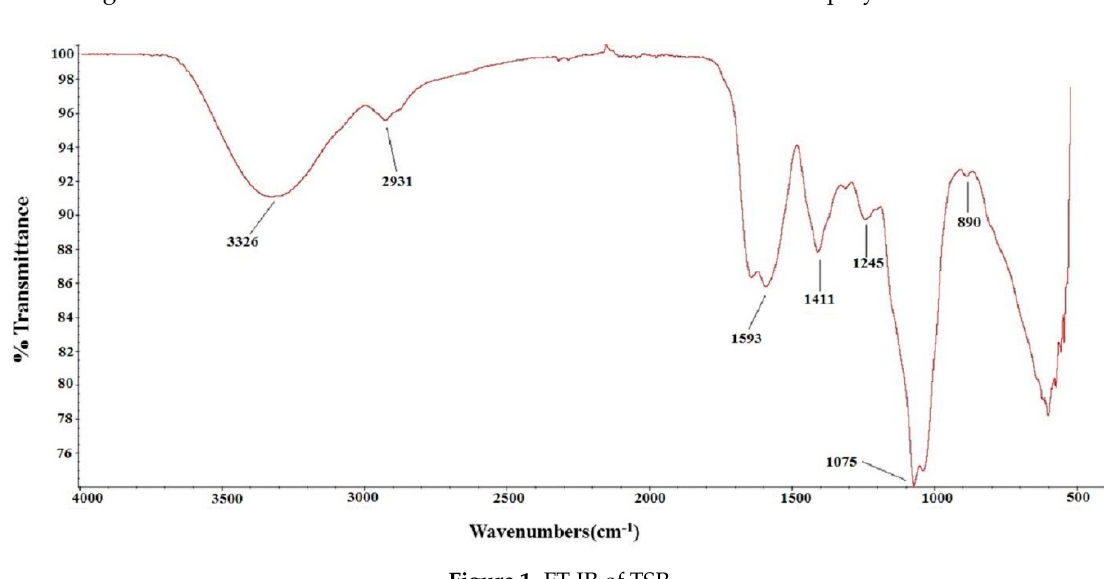
Figure 1. FT-IR of Figure 1. FT-IR of TSP.